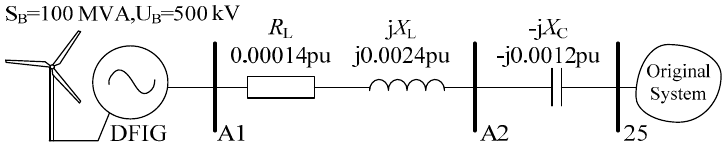
Figure 4. Wind farm connected to the IEEE 39-bus test system.